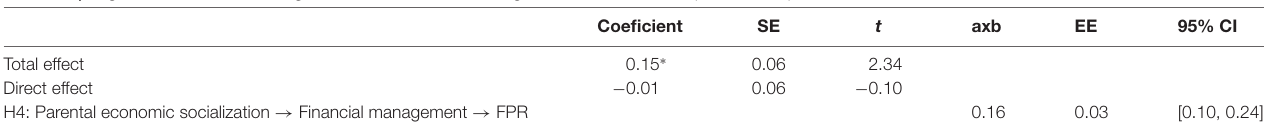
TABLE 5 | Regression results for testing mediation of financial management in the relationships between parental economic socialization and